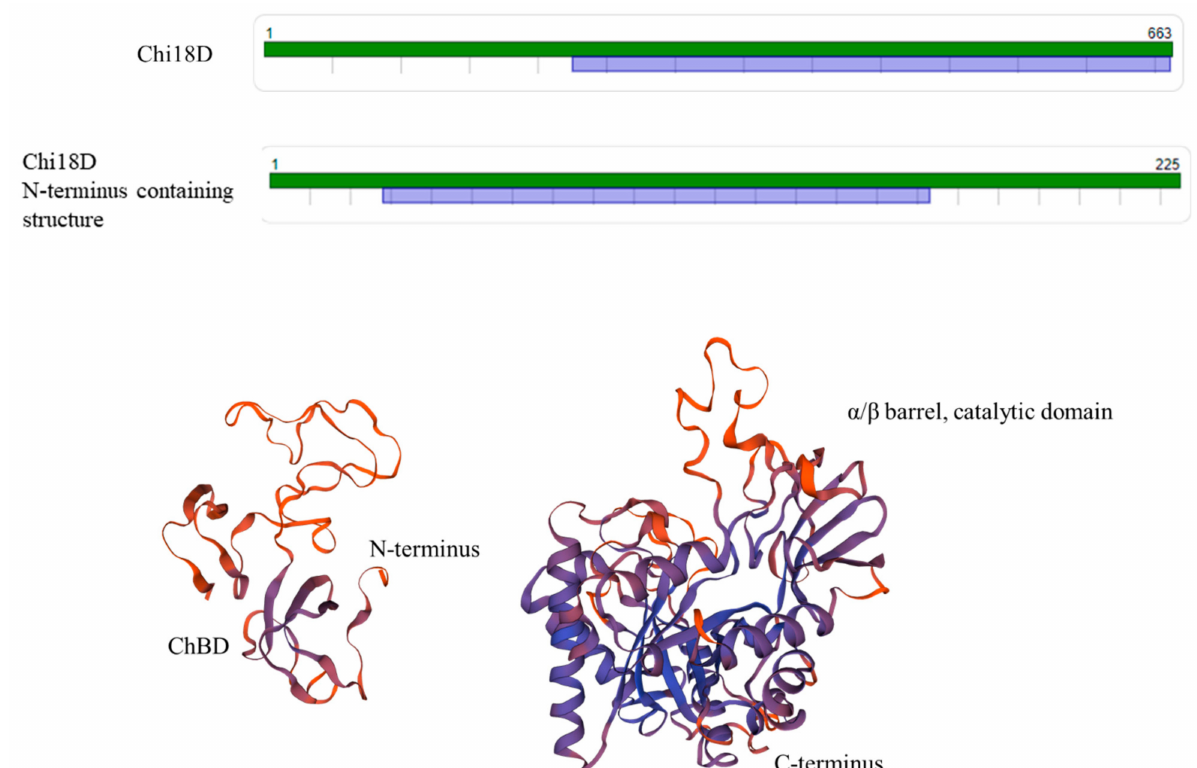
Figure 22. The predicted model map and 3D structure of Chi18D. The model templates of the N-terminal part- (31–161) and C-terminal part- (226–661) containing structures were deacetylase DA1 (PDB code: 4ny2.1.A; identity of 34.52%) and chitinase B (PDB code: 1kfw.1.A; identity of 44.01%),